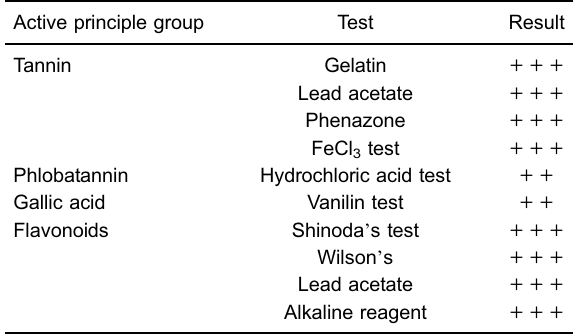
Figure 4. DPPH – scavenging by different concentrations of Beta vulgaris leaf and stalk hydroethanolic extract (4 B 512 m g/mL). Data are reported as means ± SEM of triplicates. Table 4. Phytochemical analysis results of the leaf and stalk extract of Beta vulgaris